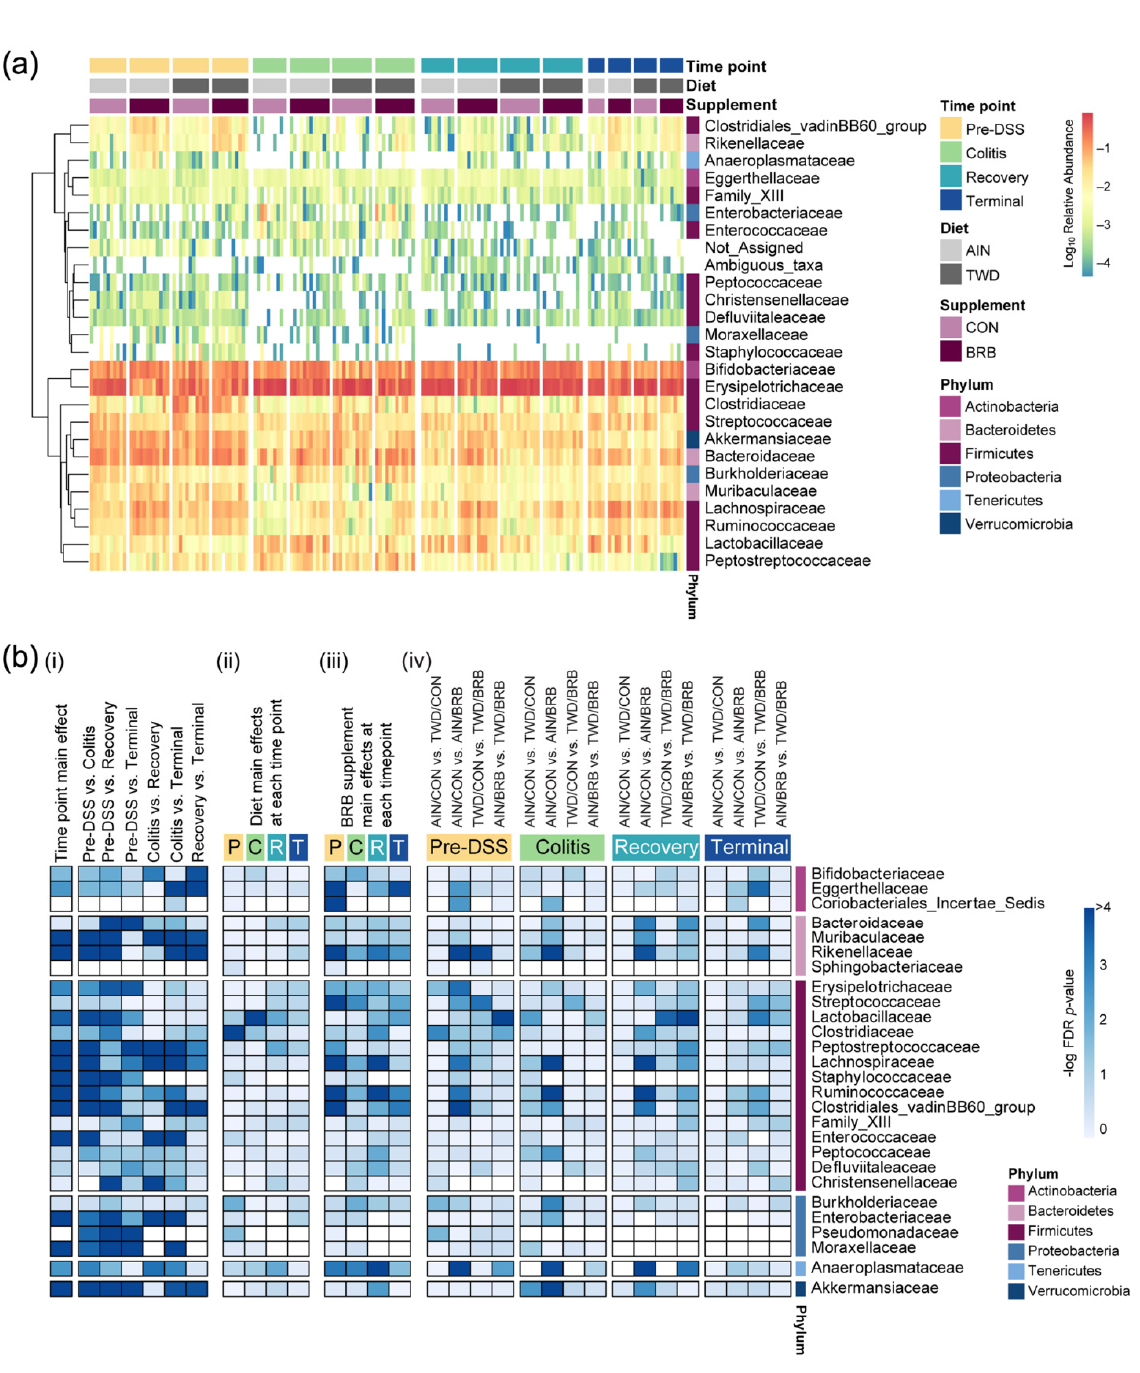
Figure 7. Relative abundance of fecal microbiome at the family taxonomic level with summary of results of metagenomeSeq statistical analyses (experiment B). ( a ) Unsupervised hierarchical cluster analysis shows the log 10 relative abundance with clustering by taxa using the Euclidean distance with average linkage. ( b ) Summary plot shows the log 10 FDR-adjusted p -values obtained from metagenomeSeq analyses of fecal microbiome profiles. All tests were determined a priori, and complete results are provided in Supplementary File S4. (i) Analyses for main effects of time point and pairwise comparisons across time points, irrespective of basal diet or BRB supplementation. (ii) Analyses for diet main effects, irrespective of BRB supplementation, at each time point. (iii) Analyses for BRB supplementation main effects, irrespective of basal diet, at each time point. (iv) Selected pairwise tests for basal diet and BRB supplement combinations within each study time point. A significant effect was inferred for FDR-adjusted p -values <0.05 (increasing blue on the color scale).